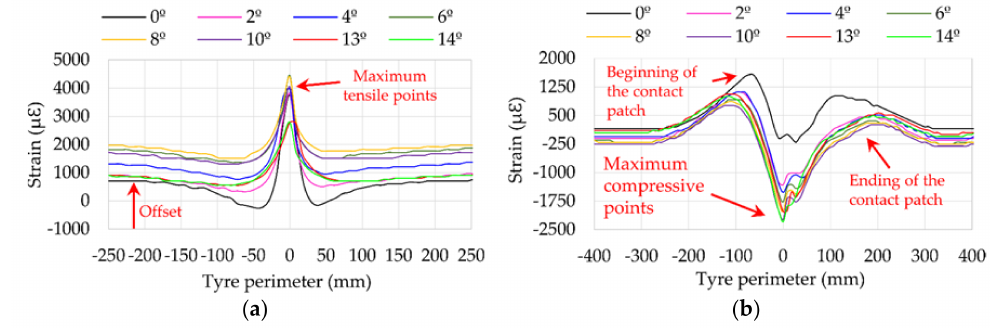
Figure 7. ( a ) Strain data curves in channel 2 ( ε x ) at 1 bar, 750 N, 30 km/h; ( b ) Strain data curves in channel 3 ( ε y1 ) at 1 bar, 750 N, 30